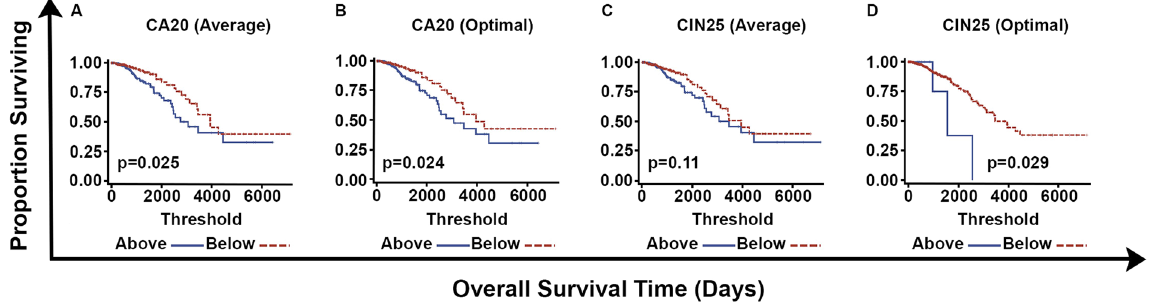
Figure 3. Plots of Kaplan-Meier product limit estimates of overall survival of patients in TCGA dataset stratified by ( A ) CA20 (average value), ( B ) CA20 (optimal threshold), ( C ) CIN25 (average value), and ( D ) CIN25 (optimal threshold) determined using the entire dataset.